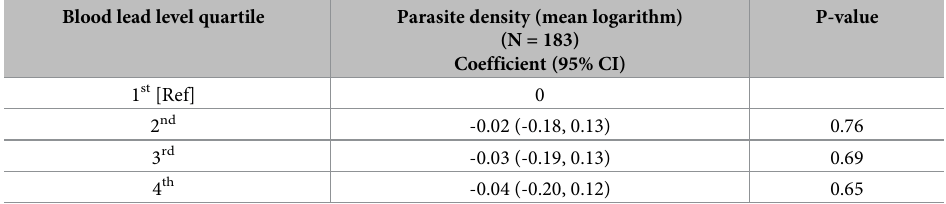
Table 5. Multivariate linear regression for associations between blood lead level quartile and mean logarithm par- asite density † . Blood lead level